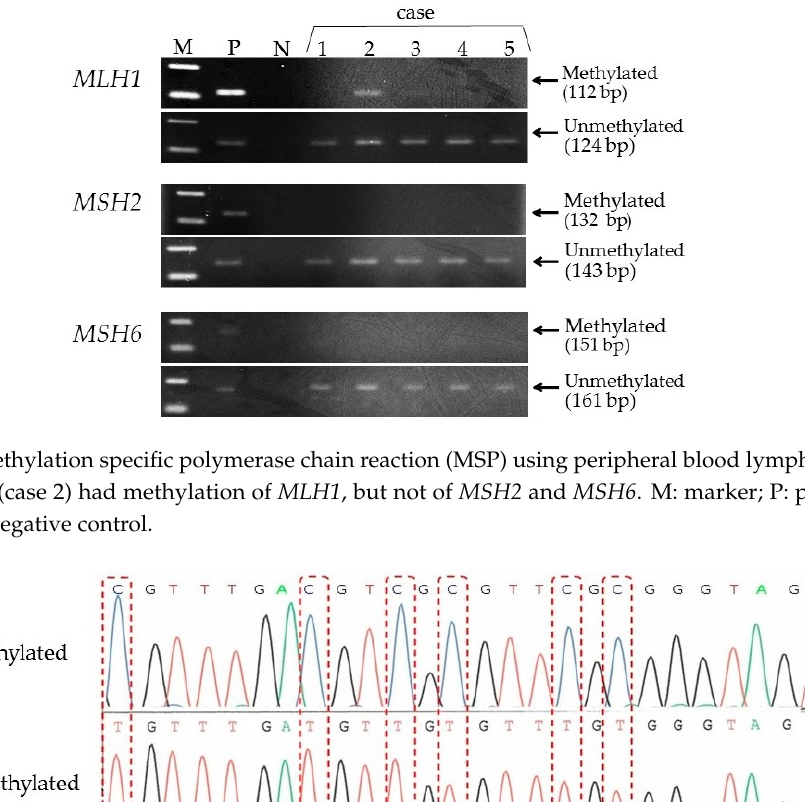
Table 3. Amsterdam II Criteria and revised Bethesda guidelines.